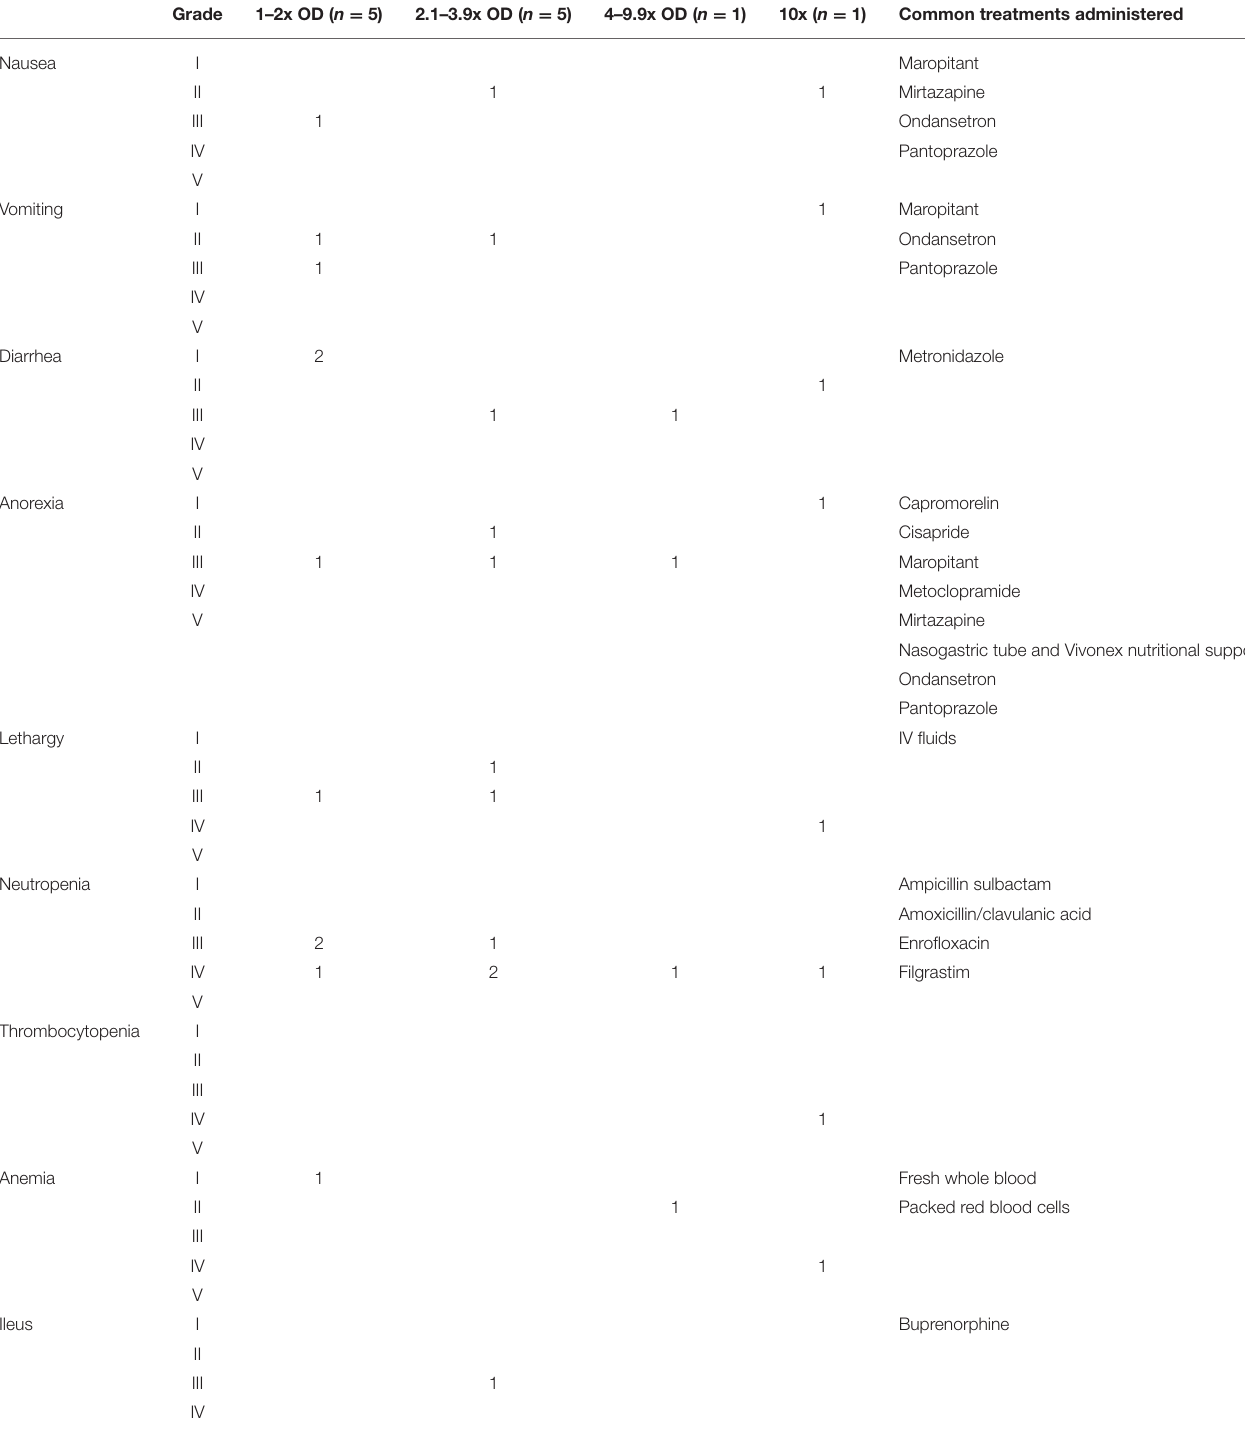
TABLE 2 | Adverse events and treatments in dogs following overdose of